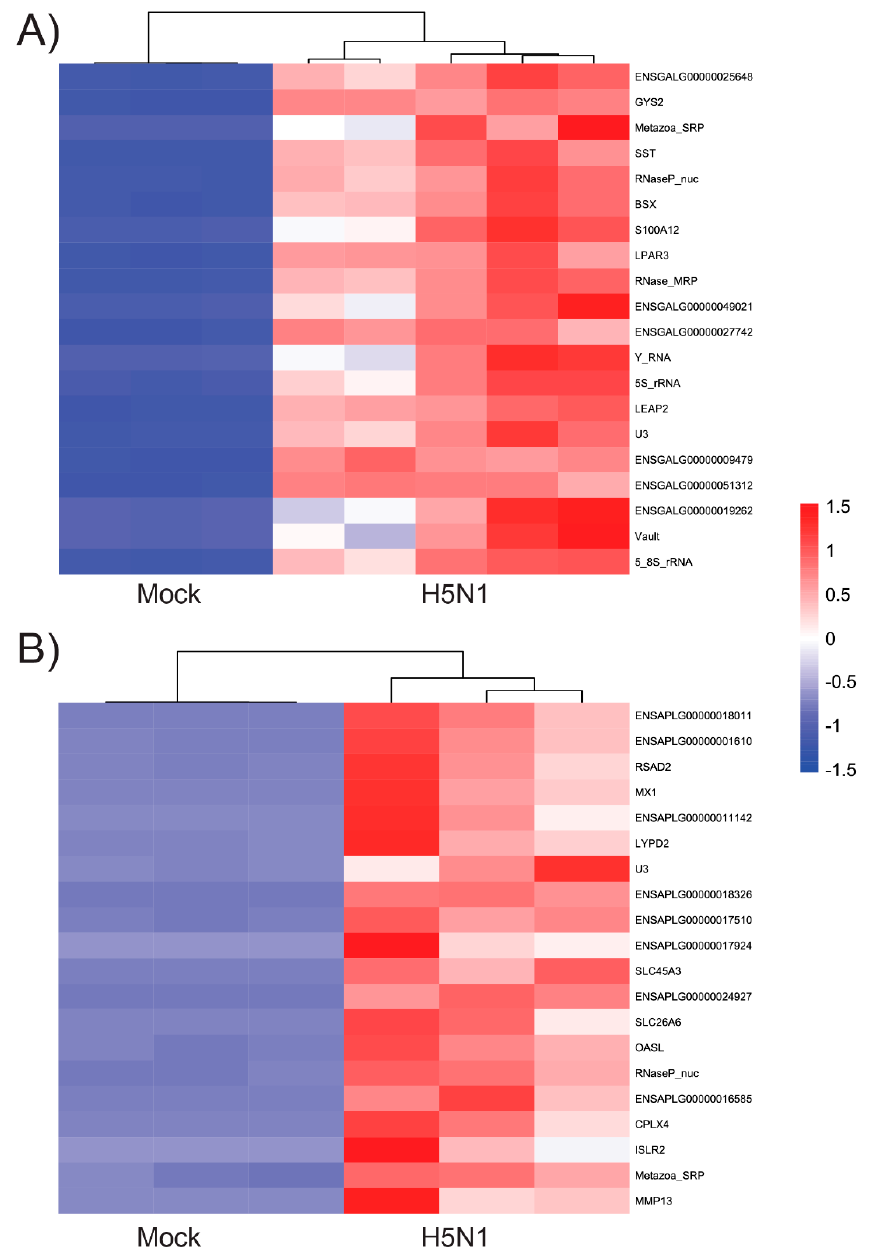
Figure 2. Heatmaps of the top 20 differentially expressed genes (the lowest q-value) of each species. Top differentially expressed genes of chicken ( A ) and duck ( B ) HPAIV VN/04(HPAI)-infected aortic endothelial cells against mock-infected cells. Table 1. Cytokine–cytokine interaction pathways in chickens and ducks.